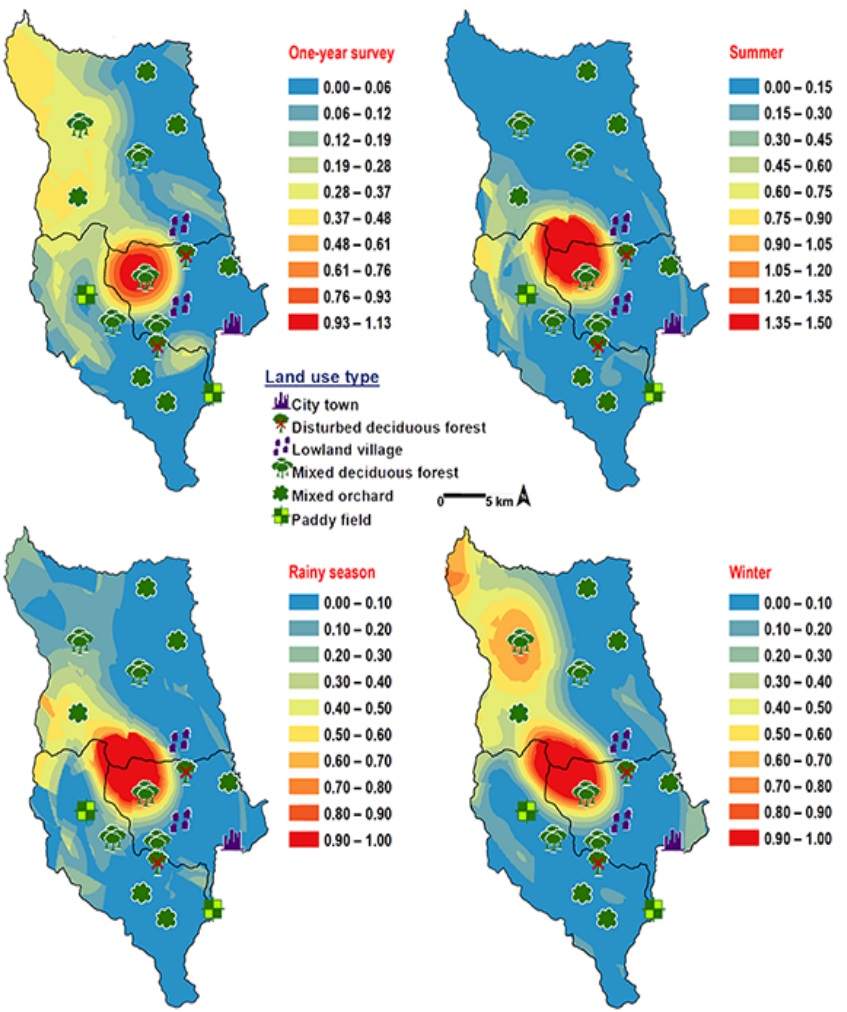
Figure 4. Predictive distribution maps of Chrysomya pinguis . The red areas symbolize the highest density of flies calculated by the analysis, while the blue areas indicate the lowest density. The scale corresponds to the natural logarithm of (fly density +1).